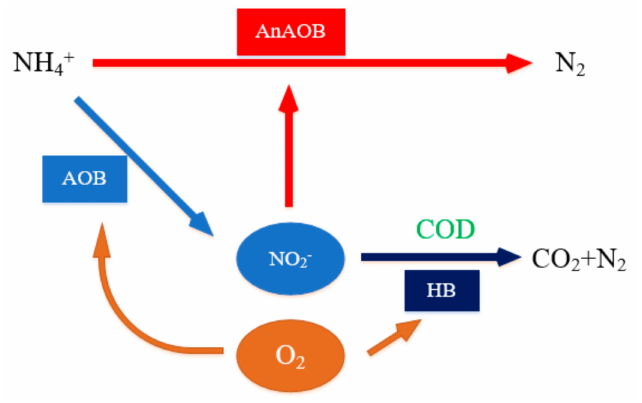
Figure 5. Competition among ammonia oxidizing bacteria (AOB), anaerobic AOB (AnAOB) and heterotrophic bacteria